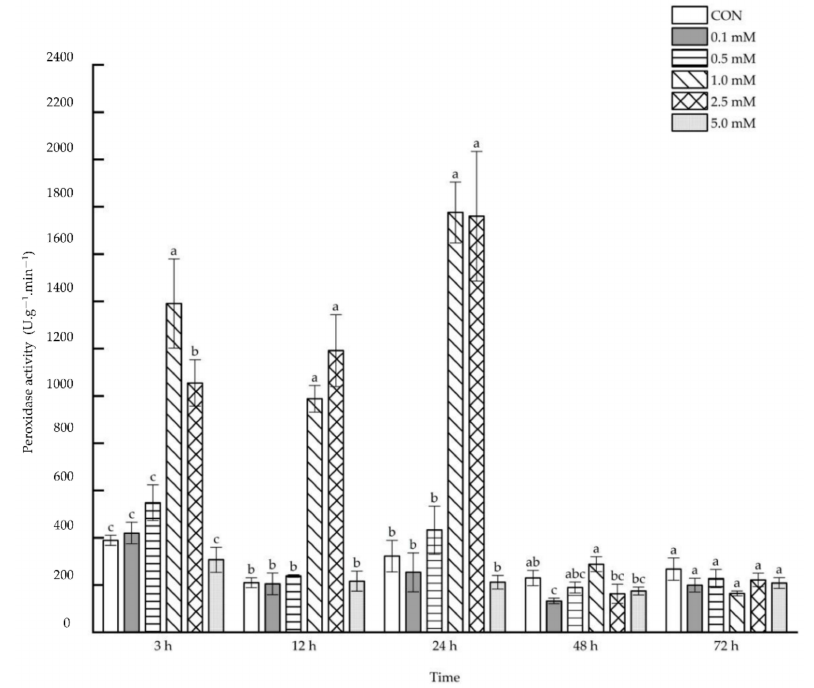
Figure 4. The direct effect of the SA concentration and post-treatment time on the peroxidase activity in leaves following exogenous foliar application. The data are presented as mean ± standard errors. The significance of data was determined by the Duncan method. The difference between different letters at the same time reached significant levels of